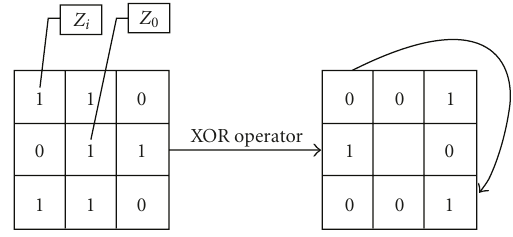
Figure 2: LGPP u , v ( Z 0 ) is a binary string 00101001.